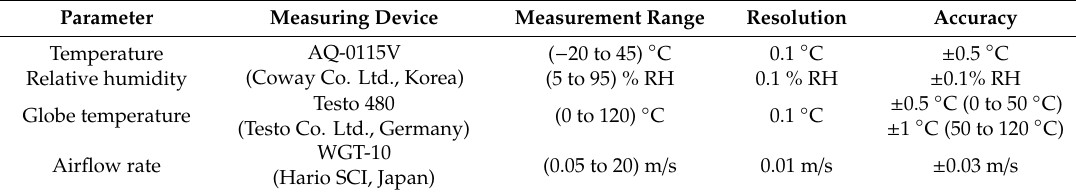
Table 2. Type and characteristics of the measuring